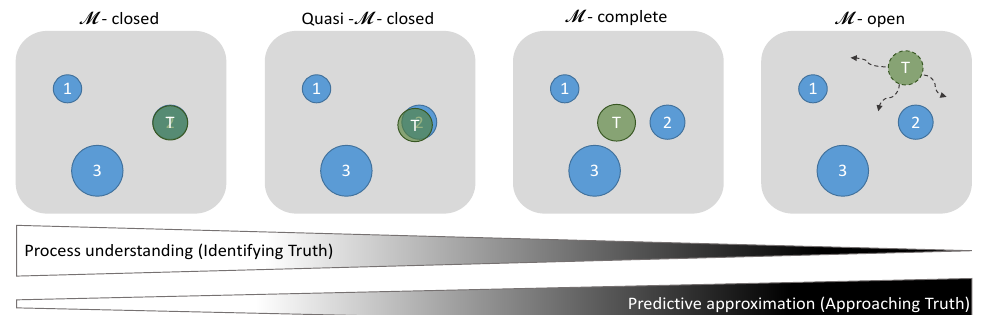
Figure 1. Illustration of M -settings as 2D projection: M -closed (left), Quasi- M -closed (center left), M -complete (center right) and M -open (right). The model set comprises three models (blue circles) of different complexity (indicated by the circle size). While in the M -closed, Quasi- M -closed and M -complete setting the true model (green circle with “T”) is static in the model space, arrows in the M -open setting depict the true model as “moving target”. The primary objective (process-understanding or predictive approximation) in each setting is visualized by the grey scale